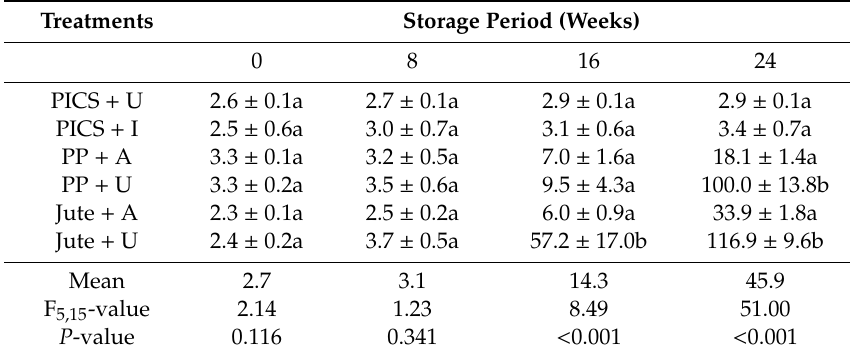
Table 2. E ff ect of treatment and storage period on dust weight (grams) of maize stored for up to 24 weeks at the Kiboko KALRO research station in Kenya. Treatments